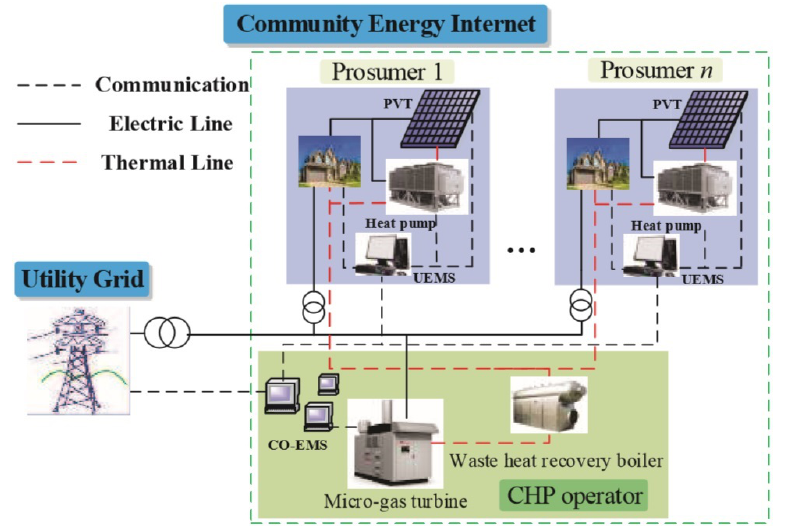
Figure 12. Structure of Community Energy Internet (CEI) with photovoltaic-thermal and heat pump (PV/T-HP) prosumers